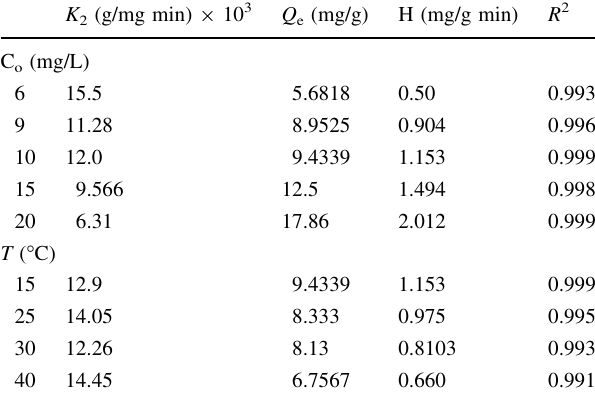
Table 3 Parameters for the pseudo-second-order equation